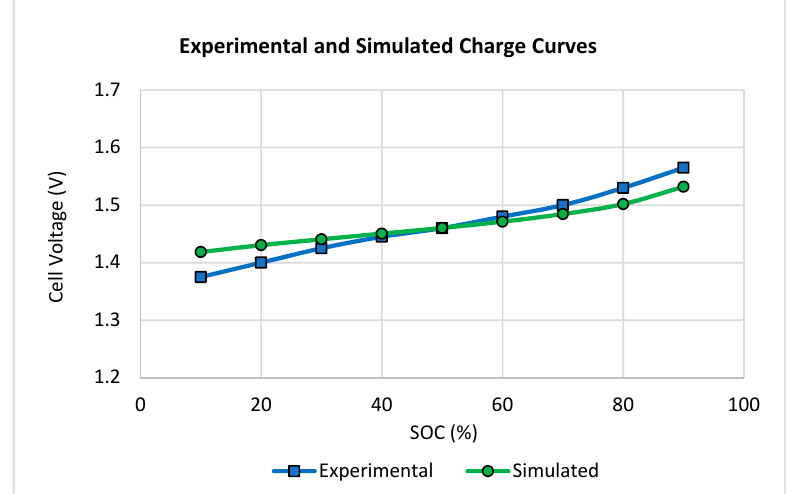
Figure 8. Experimental [8] and simulated charge curves for at 5 cm 2 cell at 40 mA cm − 2 from 10 to 90% state of charge (SOC) for model validation.